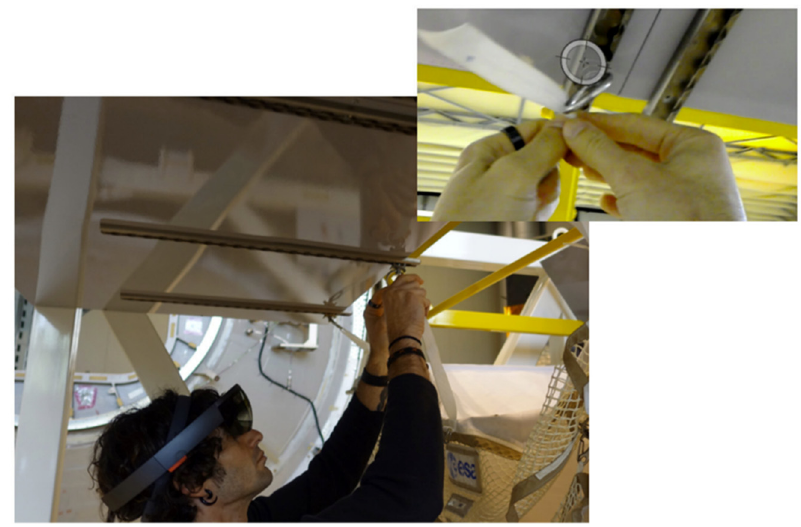
Figure 11. TSR installation in a physical mock-up of an ISS module using an AR system [68].